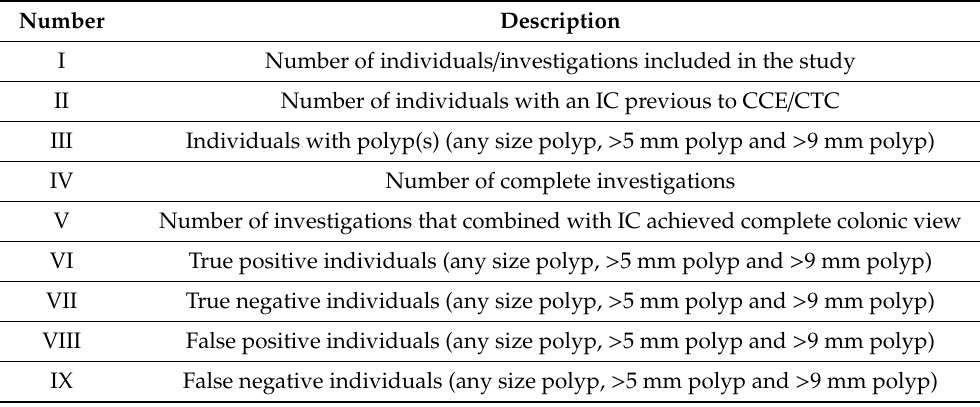
Table 1. Data extracted for statistical analyses. IC: incomplete colonoscopy, CCE: colon capsule endoscopy and CTC: computed tomography